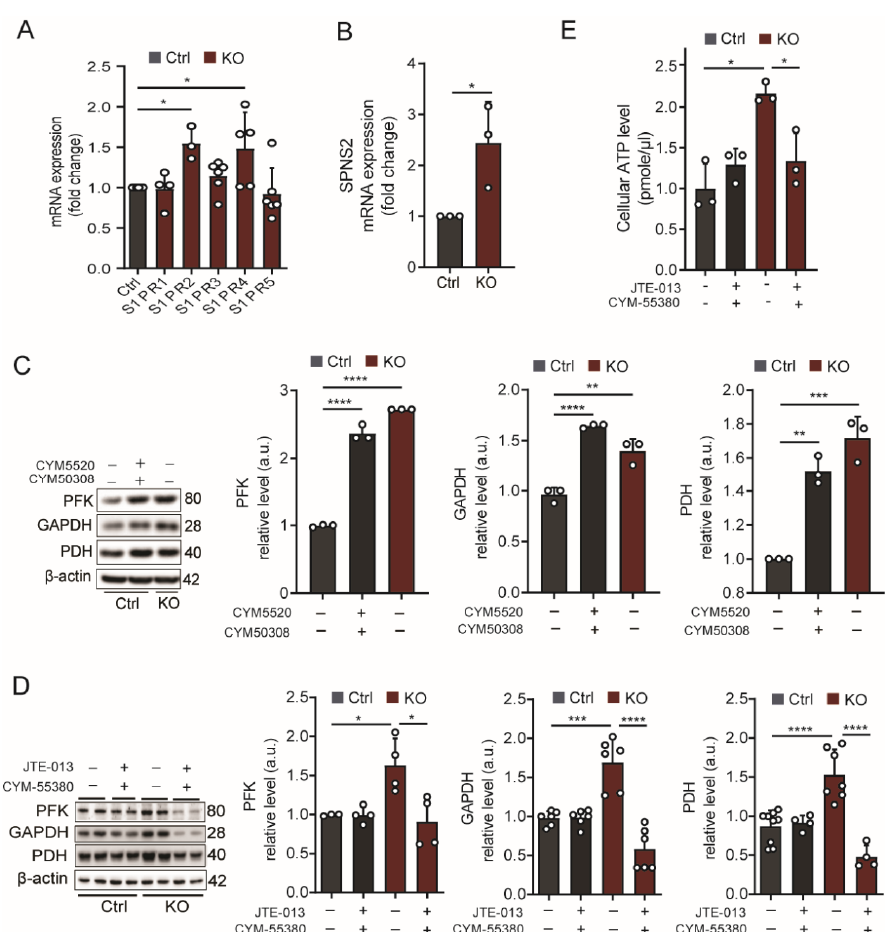
Figure 2. S1P receptors 2 and 4 mediate the effect of S1P on glucose degradation and ATP generation in SGPL1-deficient astrocytes. ( A,B ) Transcript quantification of the five S1P receptors (S1PR) and of the S1P transporter SPNS2 in SGPL1-deficient astrocytes relative to control cells (Ctrl) by qPCR using β -actin as a reference. ( C ) Protein quantification of PFK, GAPDH, and PDH following stimulation (+) of control astrocytes with a combination of specific agonists of S1PR 2 (5 µ M CYM5520) and S1PR 4 (5 µ M CYM50308) for 24 h. ( D ) Protein quantification of PFK, GAPDH, and PDH in astrocytes from control (Ctrl) or SGPL1 fl/fl/Nes (KO) mice cultured for 24 h in the absence ( − ) or presence (+) of the S1PR 2 antagonist JTE-013 (10 µ M) and the S1PR 4 antagonist CYM-55380 (10 µ M) as indicated. ( E ) Determination of ATP levels in control (Ctrl) or SGPL1-deficient astrocytes (KO) in the absence or presence of S1PR 2,4 antagonists as indicated. For all, representative immunoblots are shown with β -actin as loading control. Bars represent means ± SEM, n ≥ 3, unpaired Student’s t -test, one-way ANOVA with Bonferroni multiple comparison test; * p < 0.05, ** p < 0.001, *** p < 0.0001, **** p <